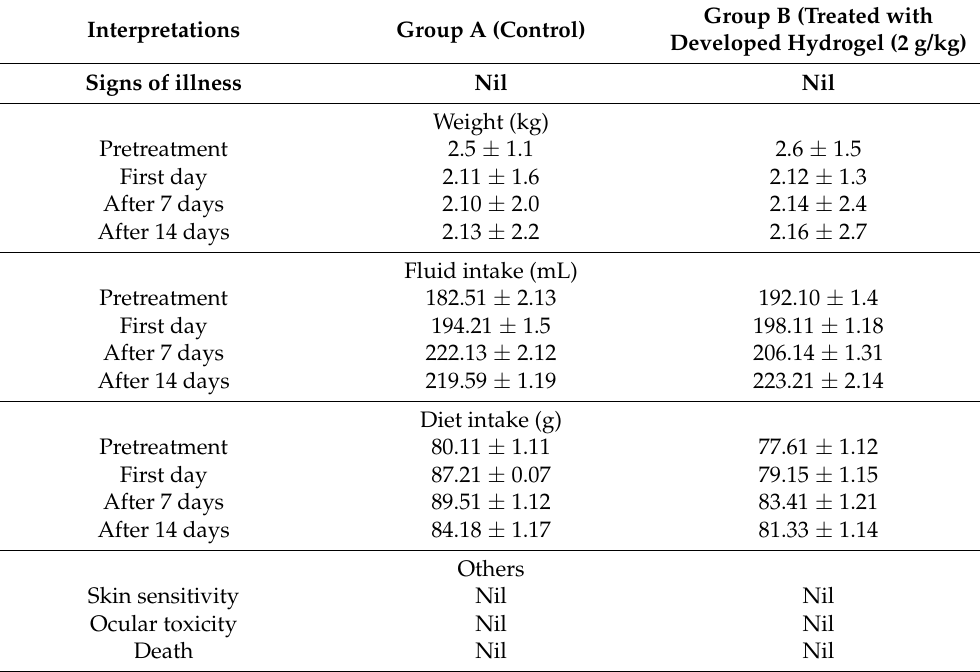
Table 2. Medical interpretation in acute oral